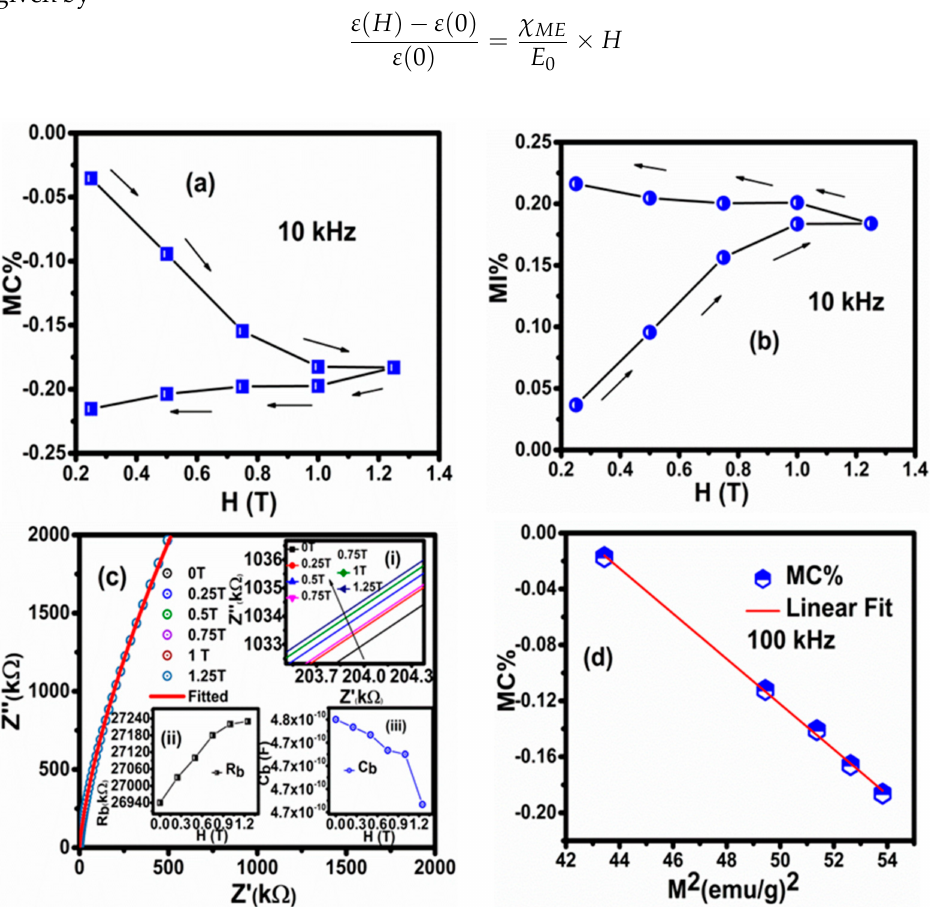
Figure 5. Variation of ( a ) MC% and ( b ) MI% with the magnetic field. ( c ) Nyquist plot for various magnetic fields, inset ( i ) is the effect of the magnetic field Nyquist plot ( ii ) bulk resistance (R b ) vs. the magnetic field ( iii ) bulk capacitance (C b ) vs. the magnetic field. ( d ) MC% vs. M 2 . ε (H) , ε (0) are the values of dielectric permittivity in the presence and absence of the magnetic field. E 0 is the applied electric field excitation (excitation voltage 1 V,